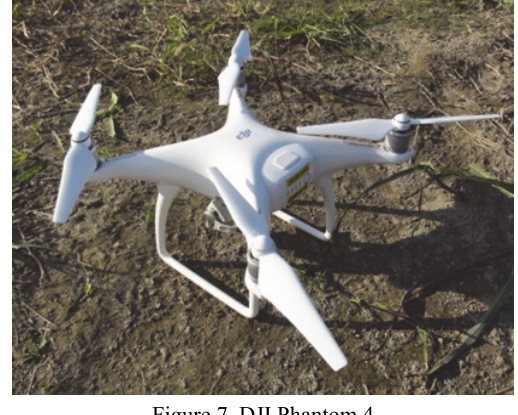
Figure 7. DJI Phantom 4